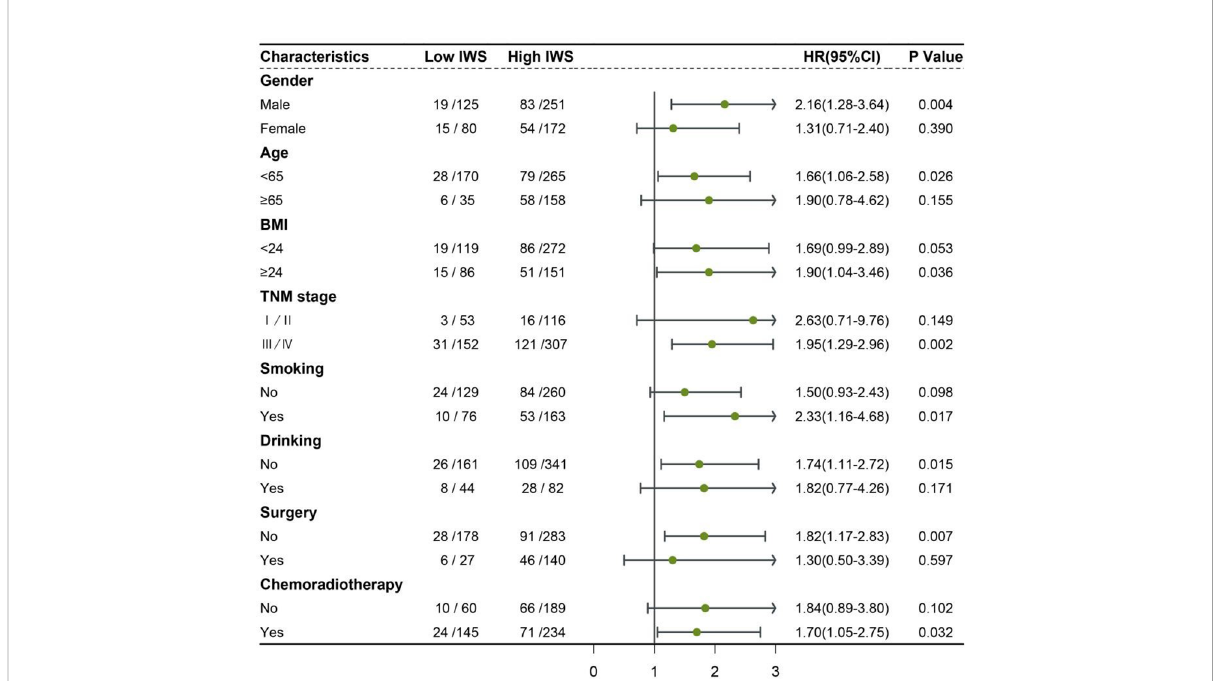
FIGURE 3 Association between the in fl ammation-water score and hazard risk of overall survival in various subgroups IWS: in fl ammation-water score (low IWS = 0 and high IWS ≥ 1) Adjusted for age, sex, BMI, TNM stage, smoking, drinking, surgery, and